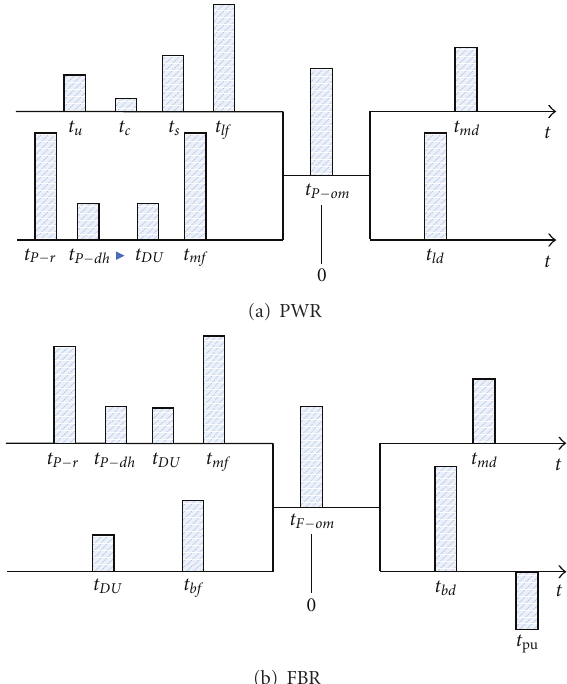
Figure 3: The cash flow in the closed fuel cycle.